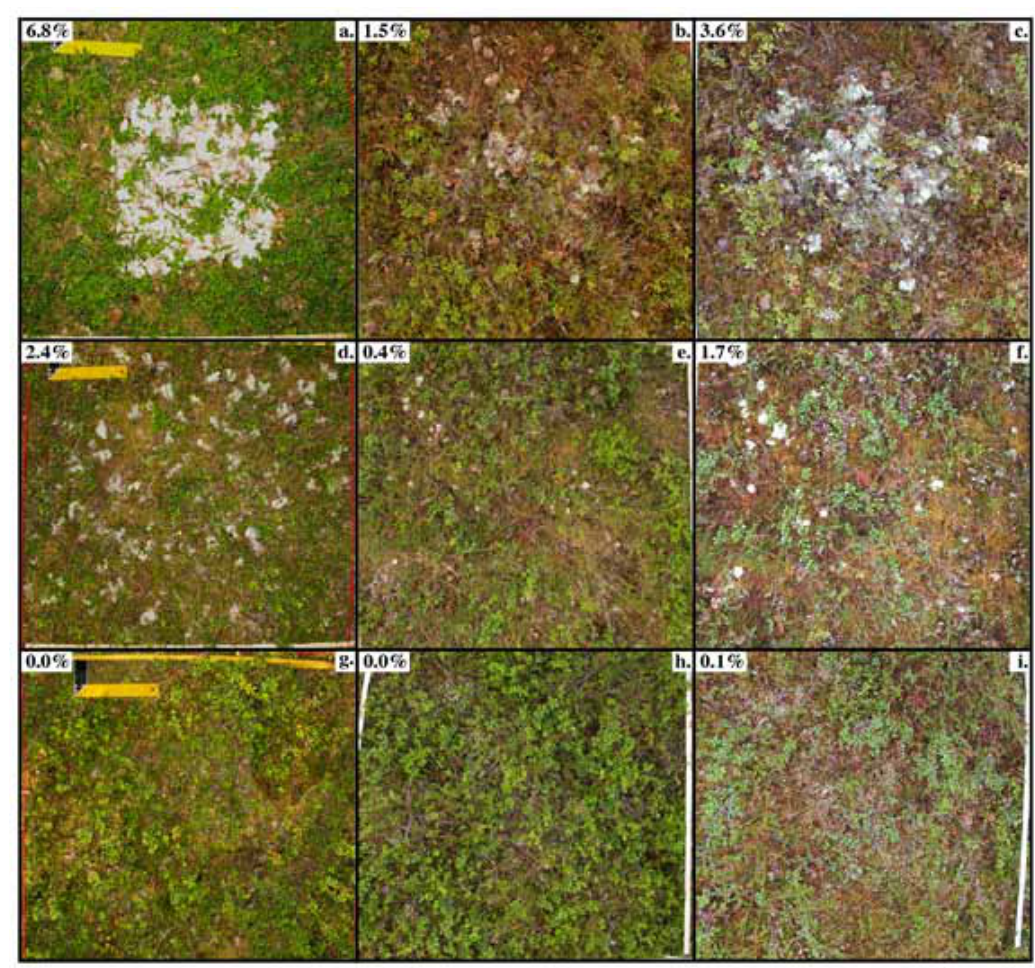
Fig. 2. Typical changes over time in lichen cover in a patch plot (a, b, c), a scatter plot (d, e, f) and a control plot (g, h, i), as shown by images taken in 2003 (left column), 2006 (centre column) and 2008 (right column). The percentage indicates the measured lichen cover in the